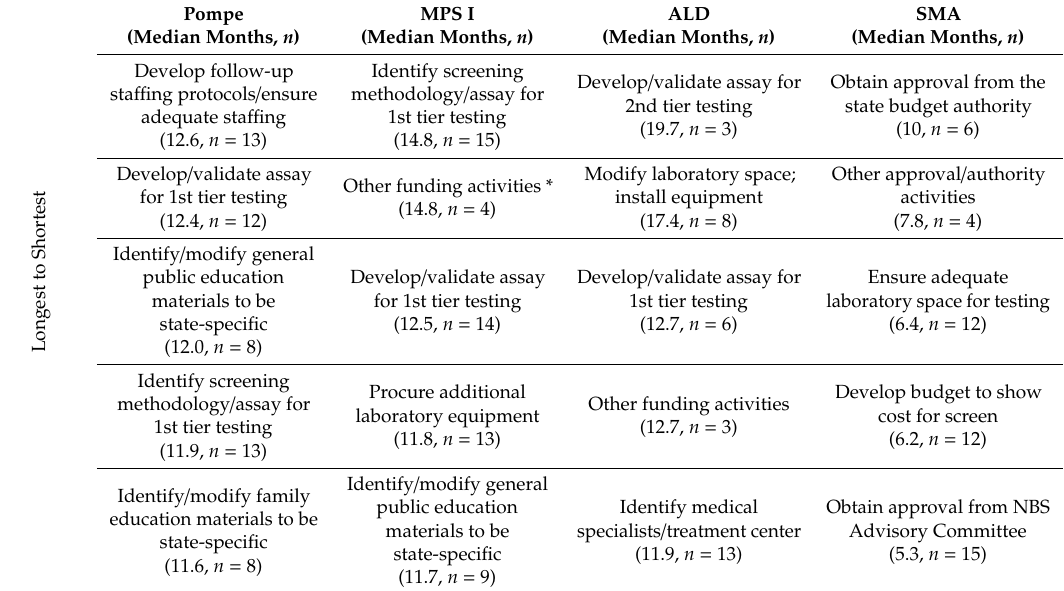
Table 4. Top Five Newborn Screening Implementation Activities with the Longest Observed Median Time to Complete, Collected from the New Disorders Readiness Tool, as of August